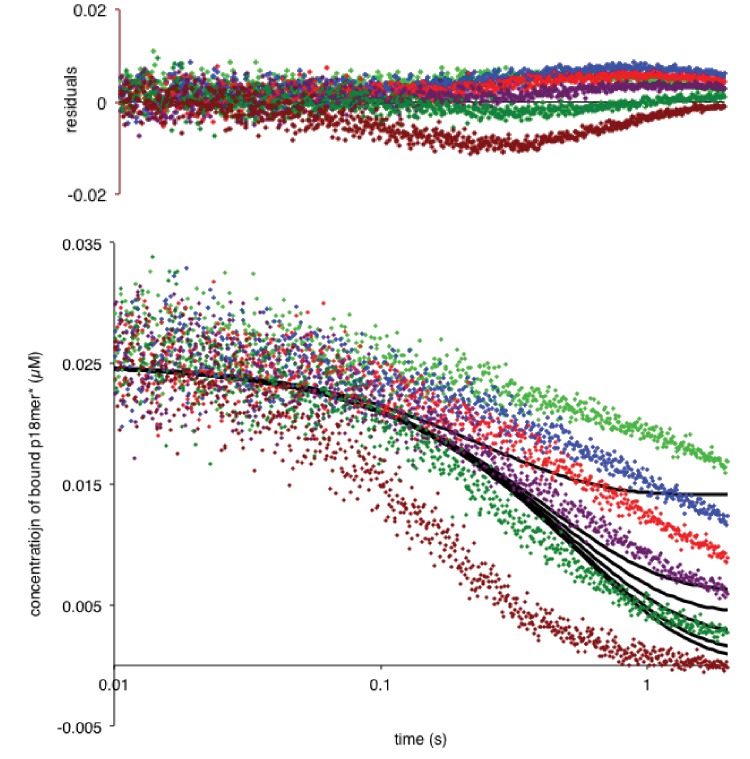
Thermodynamic parameters for DNA binding to PARP1.All values (mean and standard deviation) were derived from the kinetic parameters in Table 1.10.7554/eLife.37818.029Figure 4—figure supplement 1—source data 1.Thermodynamic parameters for DNA binding to PARP1.